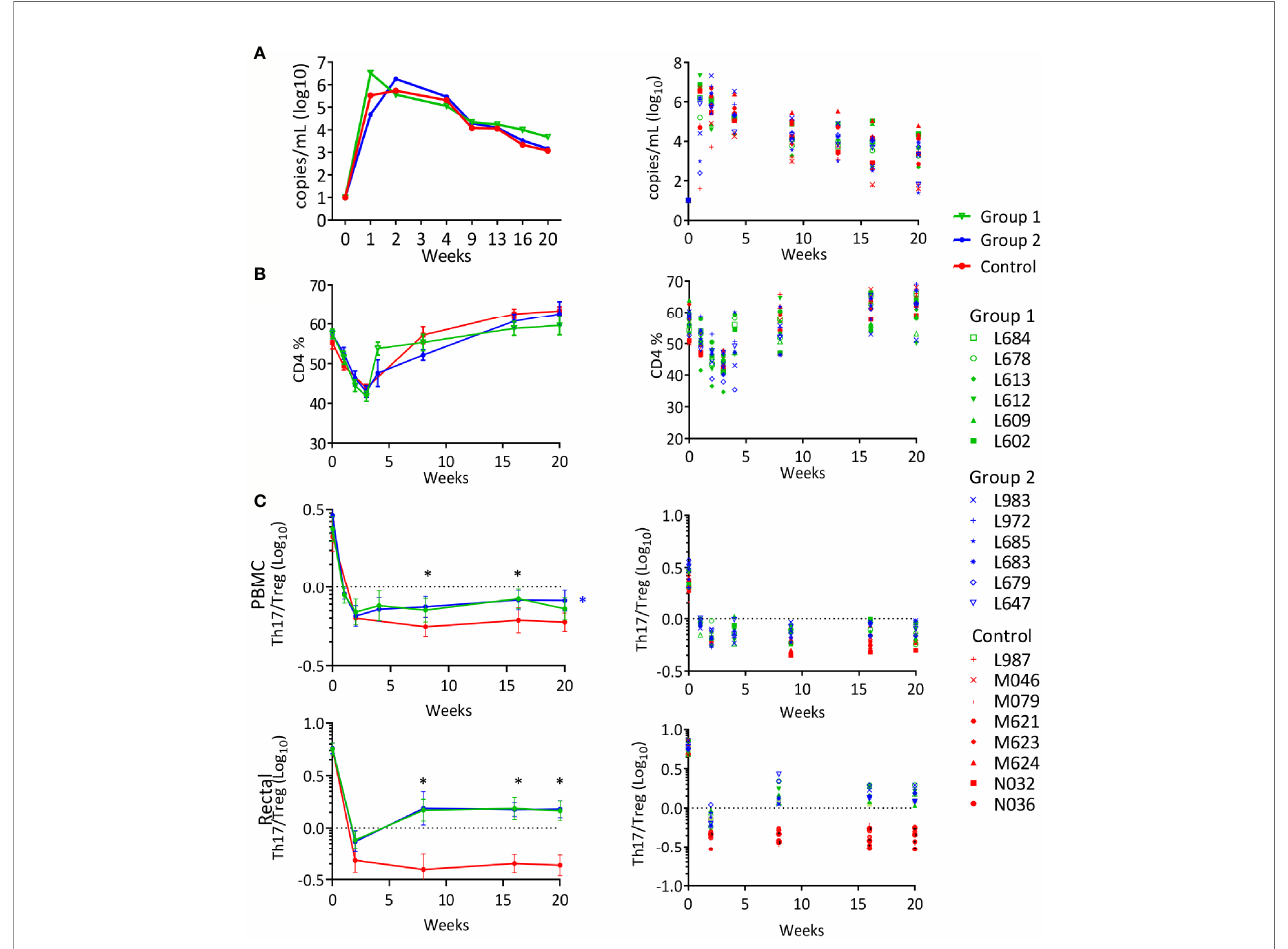
FIGURE 5 | Rectal SHIV BG505 challenge outcome: (A) Viral loads reported as geometric group means (Log 10 ) in the left panel and for each individual animal in the right panel. (B) PBMC CD4+ T-cell levels reported for each group as average percentages (left panel) or as percentages for each animal (right panel) during the course of the infection. (C) Th17/Treg ratio in PBMC (top) and rectal MNC (bottom) CD4+ T cells, reported as group average ± SE (left panel) or as individual values for each animal (right panel) during the course of the infection. Statistical signi fi cance among groups was tested with 1-way ANOVA with Sidak ’ s multiple comparisons test (*p value range: 0.0001-.021). Black asterisks indicate time points when both Group 1 and Group 2 values were signi fi cantly greater than those in the control group. The blue asterisk in the PBMC panel indicates signi fi cance for Group 2 value vs. control